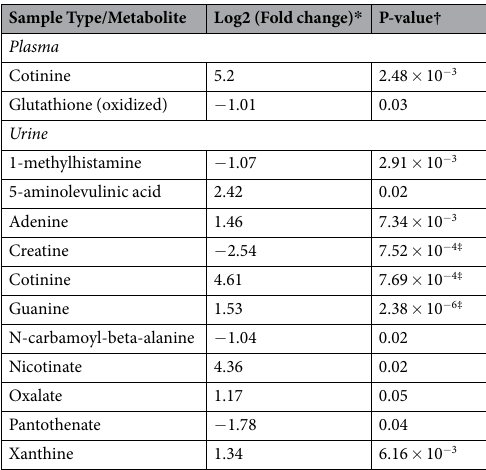
Table 2. Metabolites with differential concentrations following exposure to chronic cigarette smoke exposure in wild-type (Hhip + / + ) mice. * Negative values indicate lower concentration in wild type Hhip + / + mice exposed to chronic cigarette smoke (minimum 2x fold change). † Student’s t-test p-value. ‡ Denotes significance at a false discovery rate (FDR) < 0.05. No metabolites met the thresholds for significance in lung tissue.